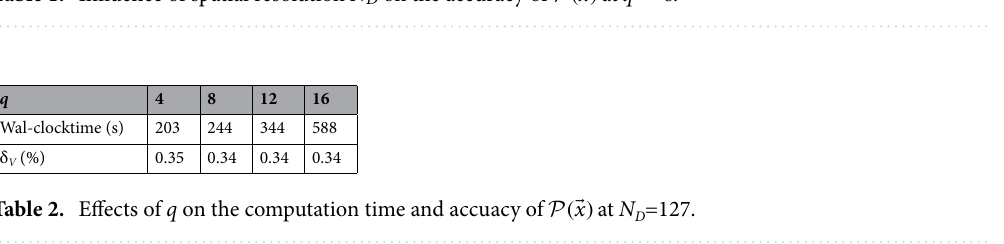
Table 1. Influence of spatial resolution N D on the accuracy of P (